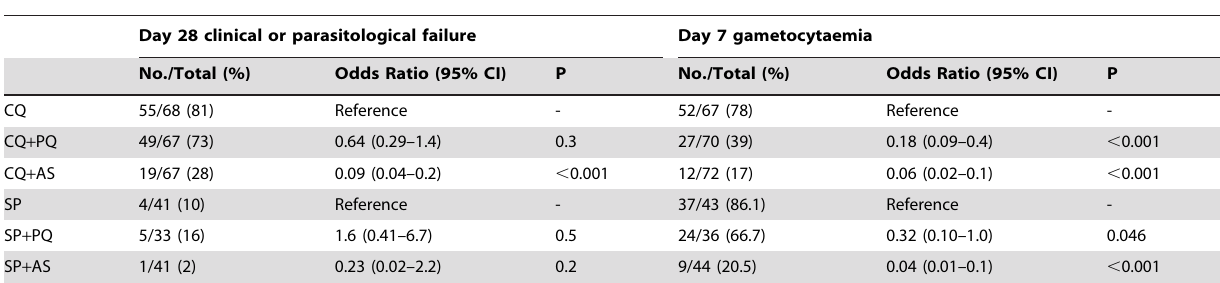
Table 3. Clinical and parasitological failure rates at 28 days follow-up and for gametocytaemia at day 7.